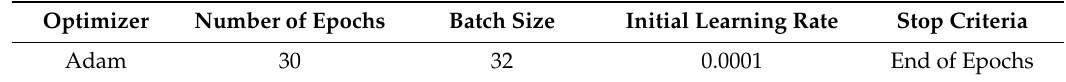
Table 5. Parameters for training CNN models in our